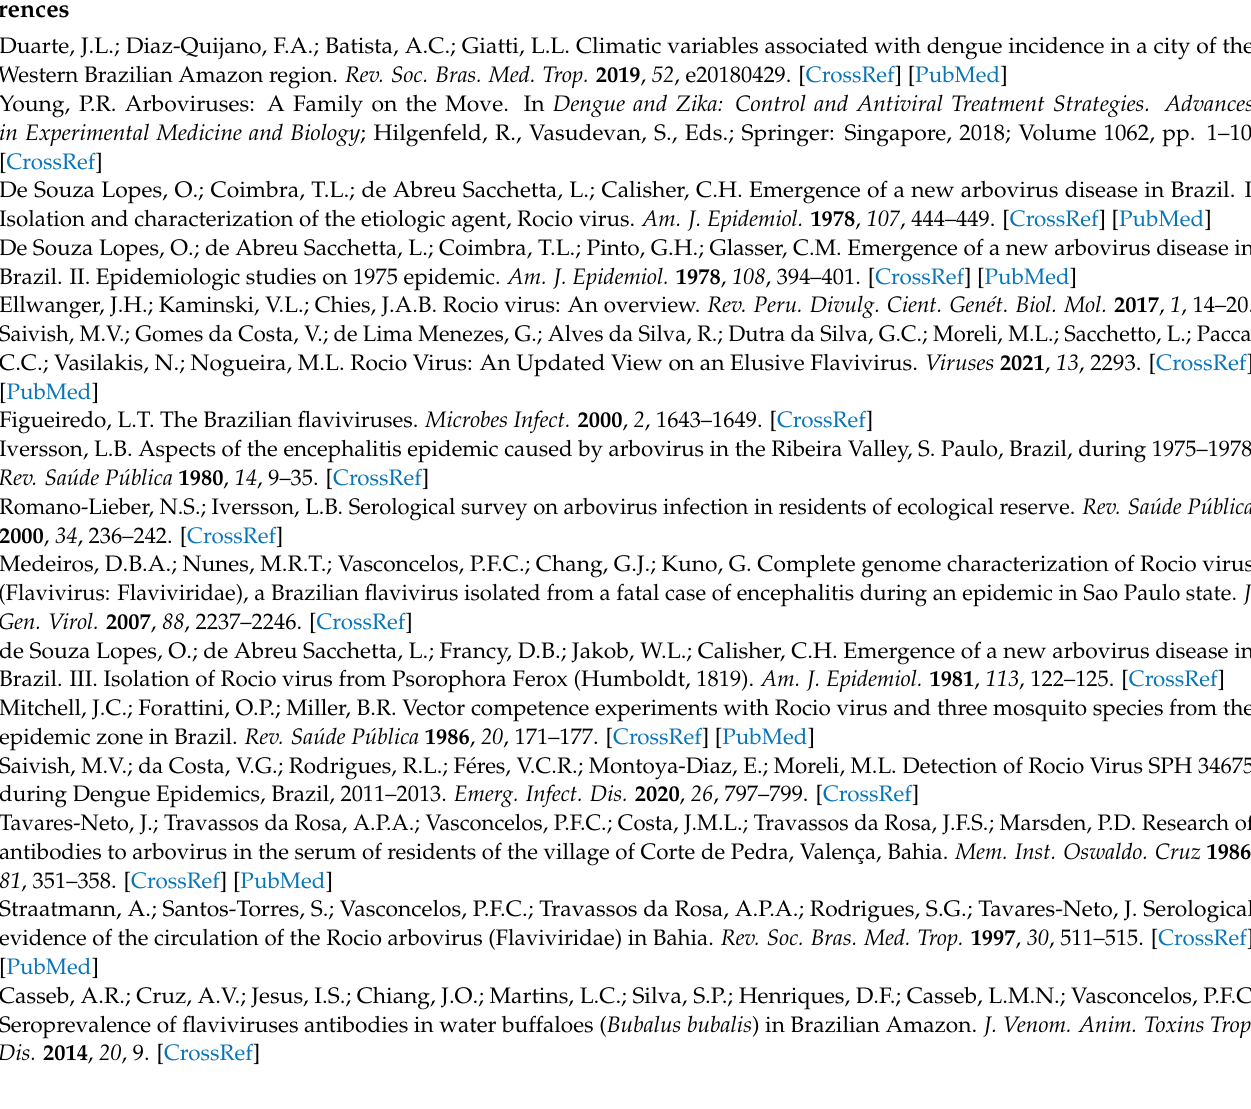
Table S2: Docking results for selected drugs available at RENAME and ROCV proteins; Figure S1: NS1 and NSI-ITC molecular dynamics simulation